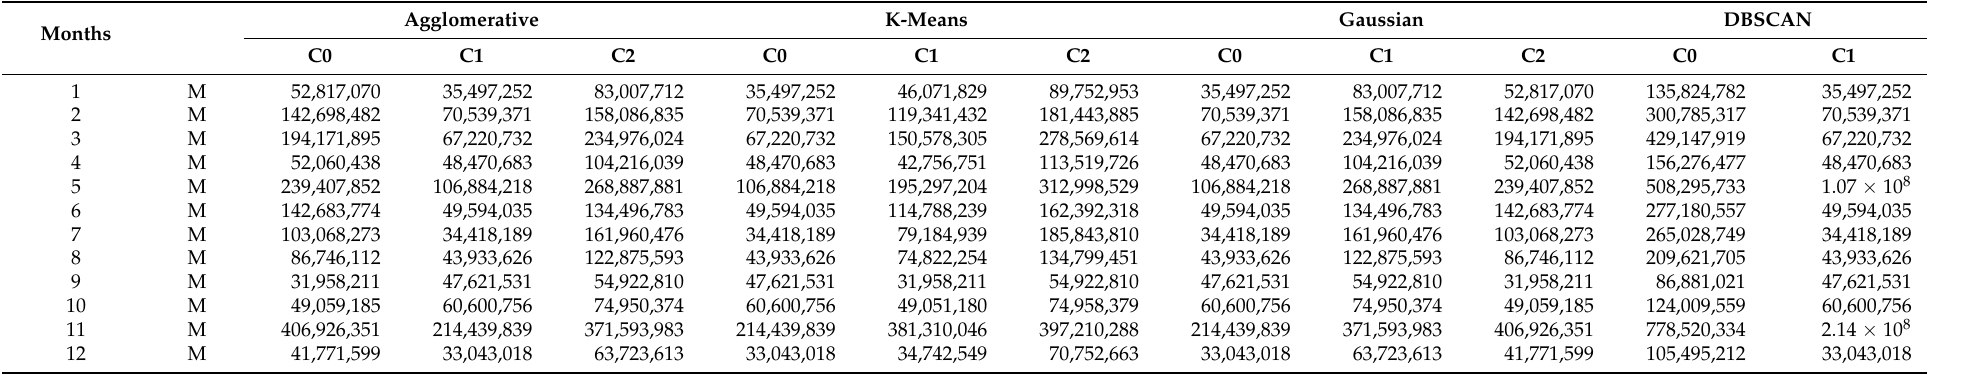
Table 11. Month-wise monetary value for different algorithm